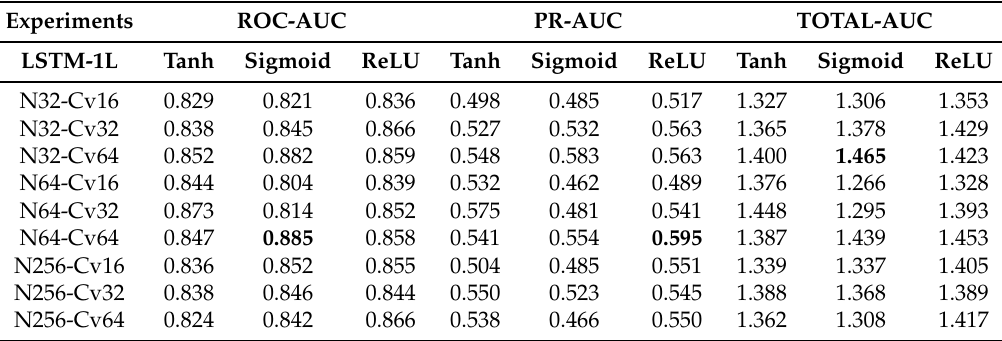
Table 3. ROC and PR as test results of one layer LSTM with various parameters changes. Experiments ROC-AUC PR-AUC TOTAL-AUC LSTM-1L Tanh ReLU Tanh